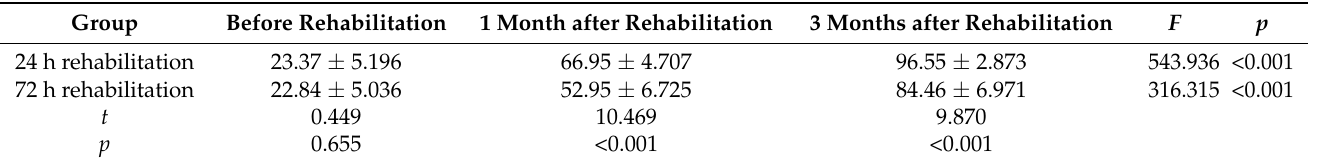
Table 3. The daily living ability scores of the acute ischemic stroke patients before and after rehabili- tation ( x ± s, n = 75).